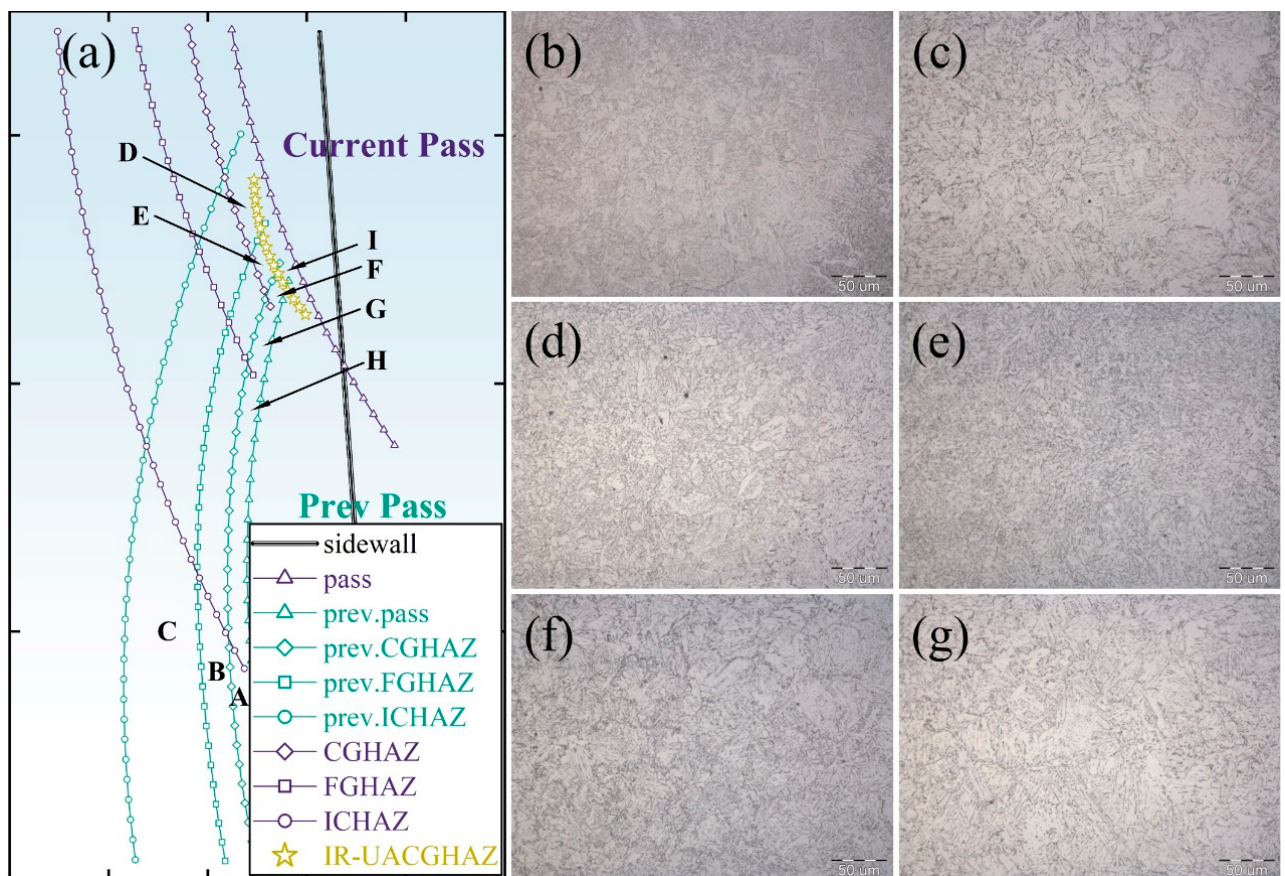
Figure 9. Overlapping patterns of the coarse grain heat-affected zones and the microstructures at the typical zones (with a magnification of 500): ( a ) distribution of CG-HAZs; ( b ) A: CG-HAZ; ( c ) F: UACG-HAZ; ( d ) G: SCRCG-HAZ; ( e ) H: IRCG-HAZ, near to the reference curve FGHAZ; ( f ) H: IRCG-HAZ, far away from the reference curve FGHAZ; ( g ) I: IR-UACG-HAZ.